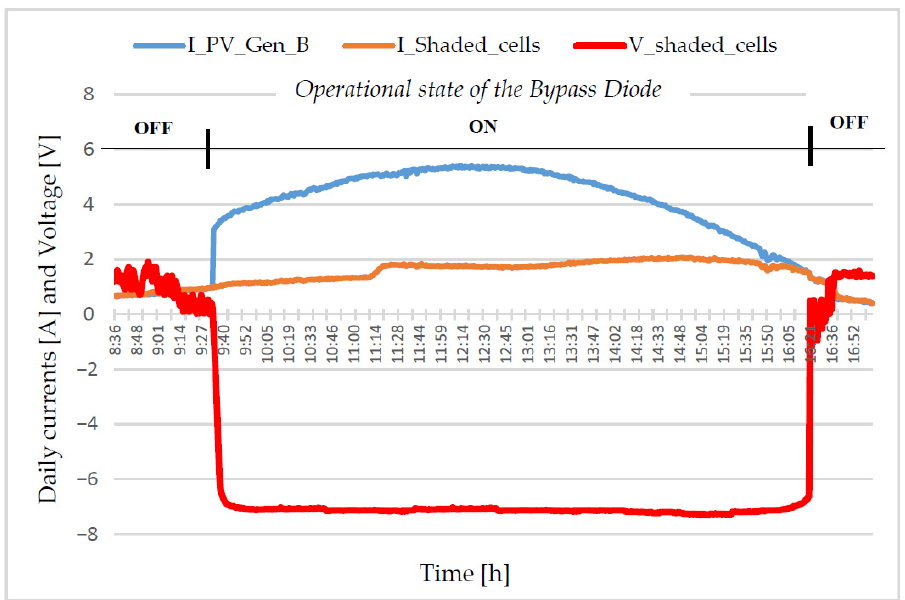
Figure 10. Daily curves of (i) the current of the PV generator B (I_PV_Gen_B), (ii) the current (I_Shaded_cells), and (iii) the voltage (V_Shaded_cells) of the three shaded cells of the submodule of the PV generator B, when the bypass diode intervened for a long time.